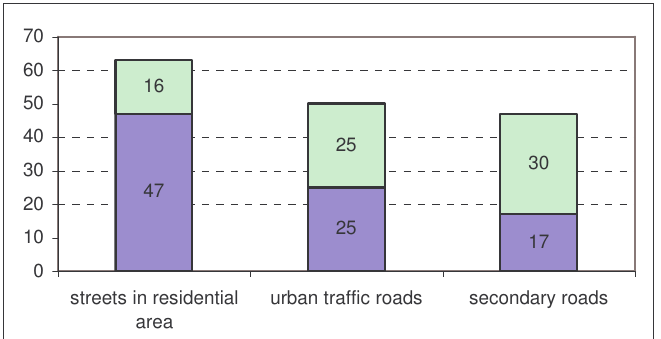
Figure 6. Firm (dark) or opportunistic ISA acceptance, per type of road (% of